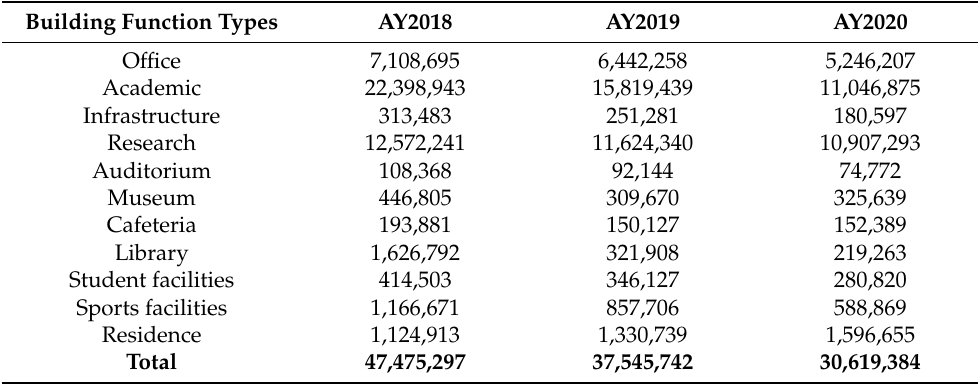
Table 3. The yearly electricity consumptions (kWh) from AY2018 to AY2020 based on the building function